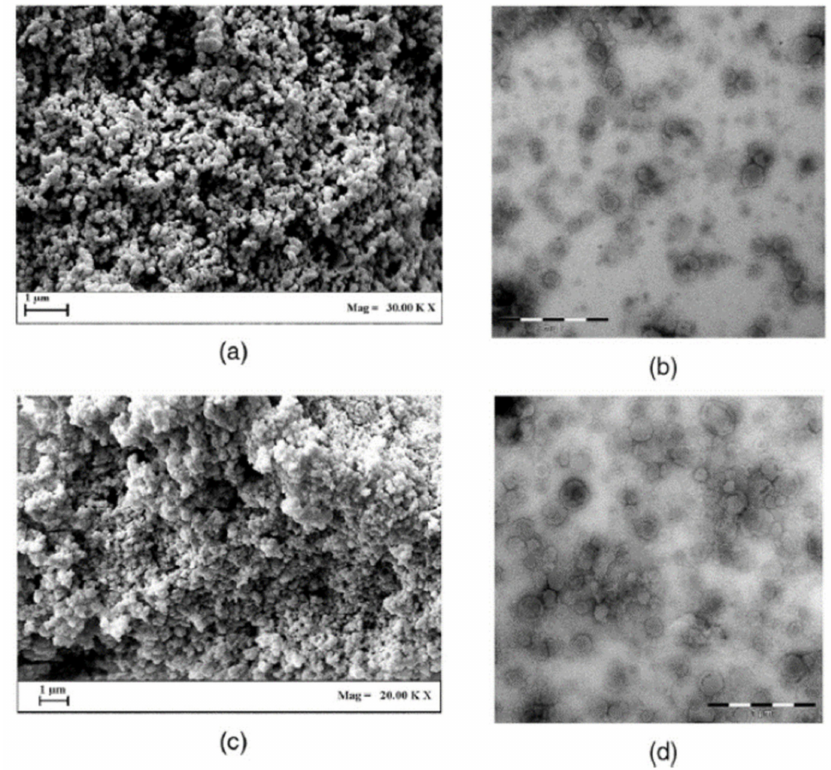
Figure 7. Scanning electron microscope (( a , c ) at di ff erent magnification) and transmission electron microscope (( b , d ) at di ff erent magnification) images of liposomes loaded with eugenol processed at di ff erent conditions